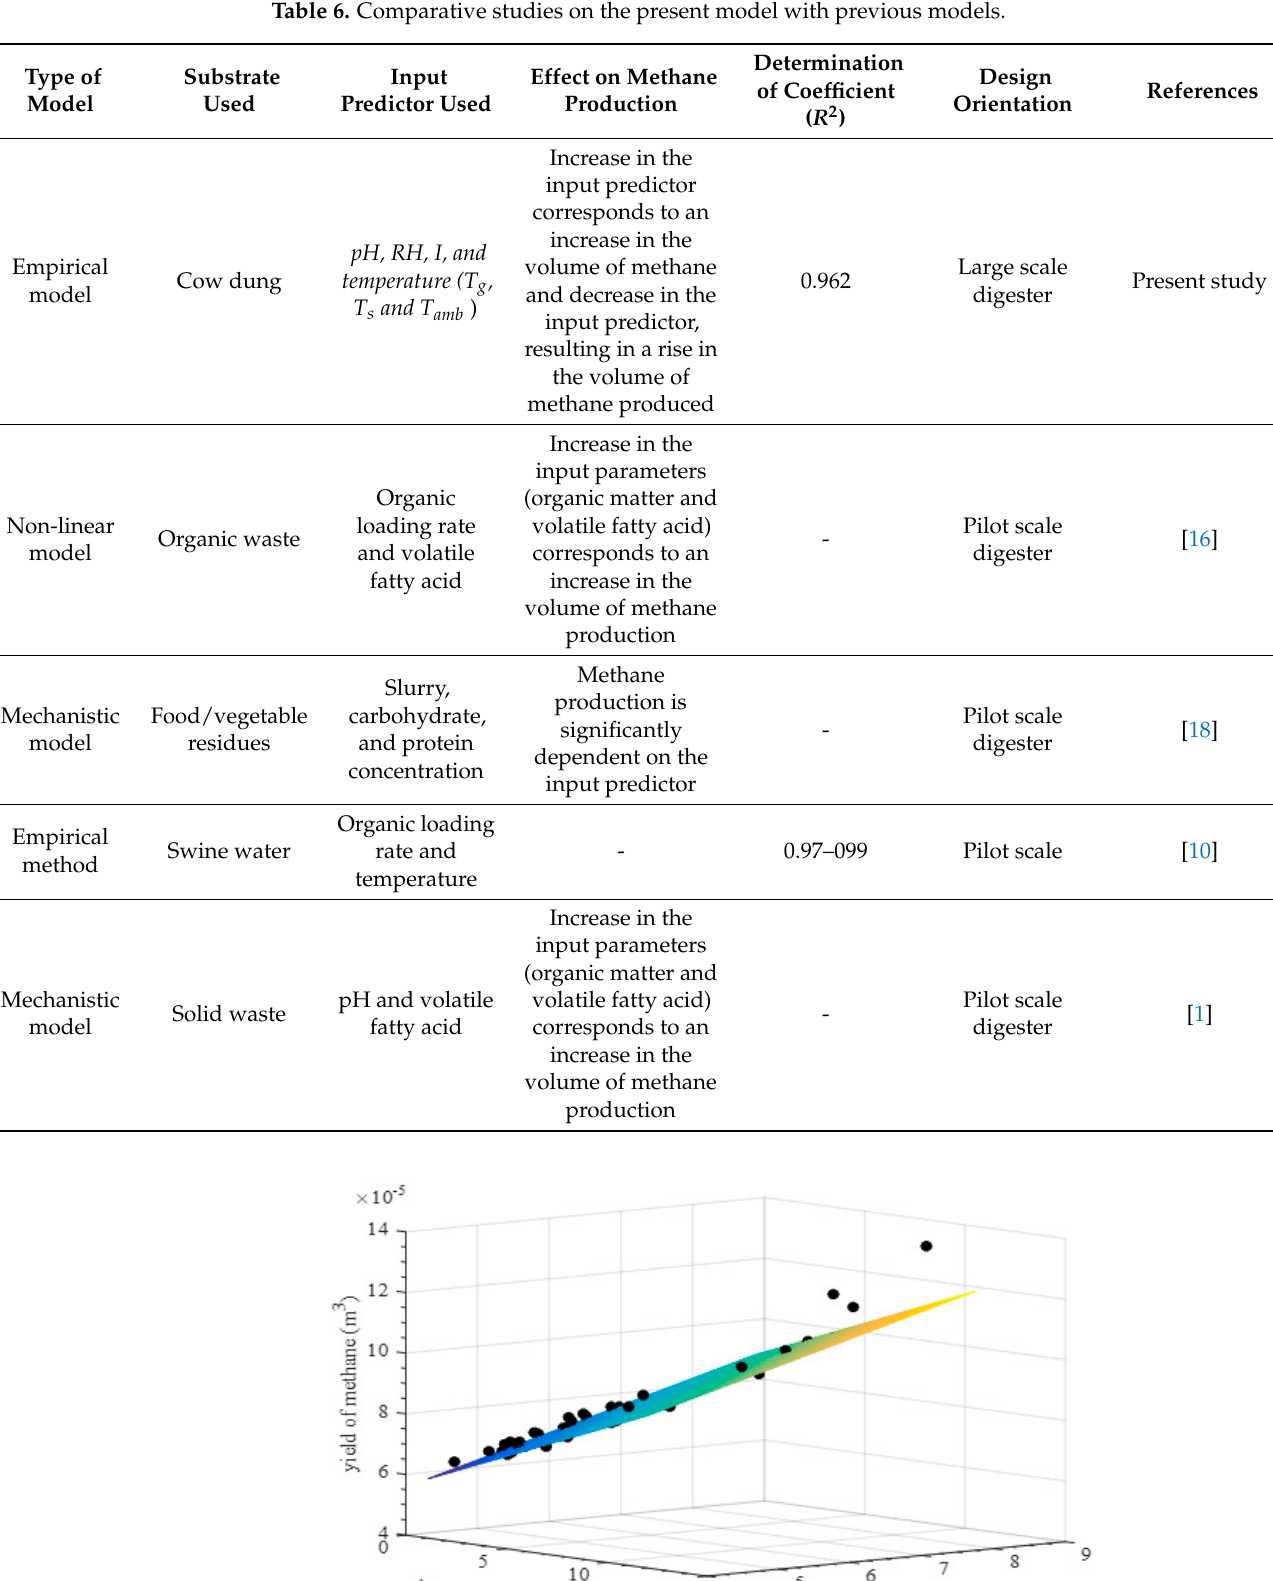
Table 6. Comparative studies on the present model with previous models.